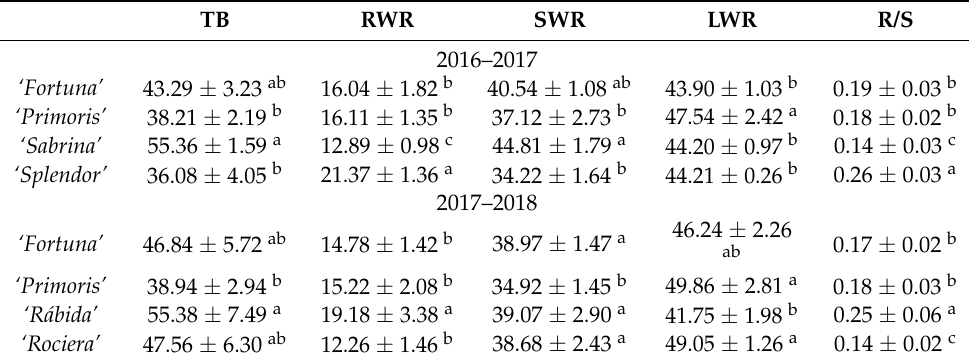
Table 2. Mean values ( ± SE; n = 6) of total plant biomass (TB; g Dw) root weight ratio (RWR), shoot weight ratio (SWR), leaf weight ratio (LWR) and root/shoot ratio (R/S) across the five strawberry cultivars in the T100 water treatment. Different superscript letters indicate significant differences among cultivars ( p <